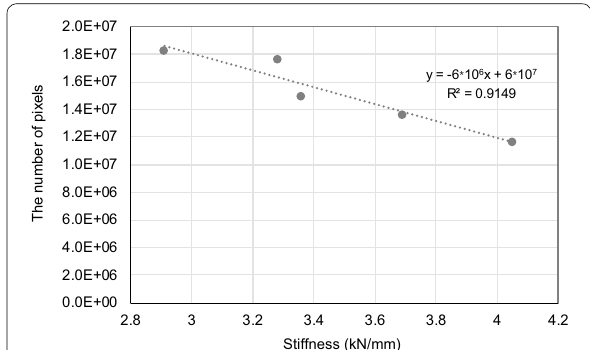
Fig. 14 Correlation between stiffness and the number of pixels from the proposed CNN